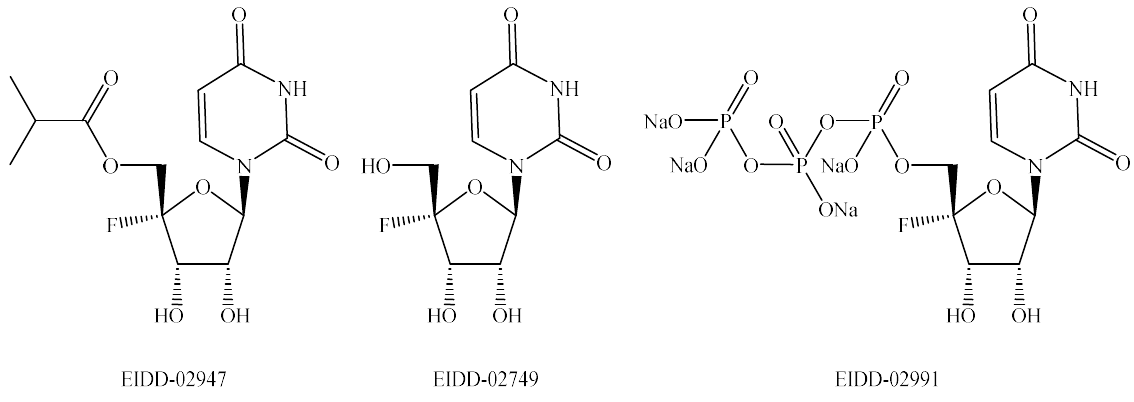
Figure 2. Chemical structures of EIDD-02749, EIDD-02991, and EIDD-02947.